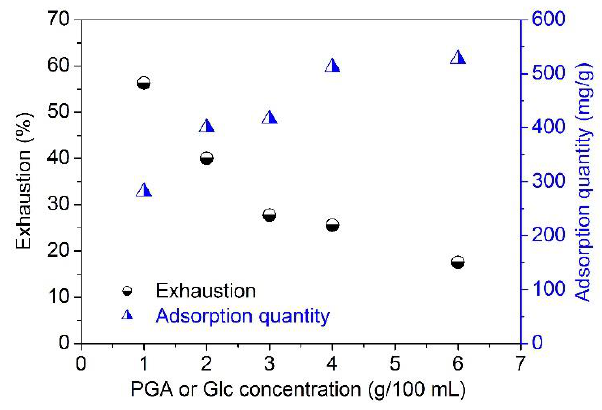
Figure 4. Exhaustion and adsorption quantity of the PGA/Glc reaction products at various concentrations on silk